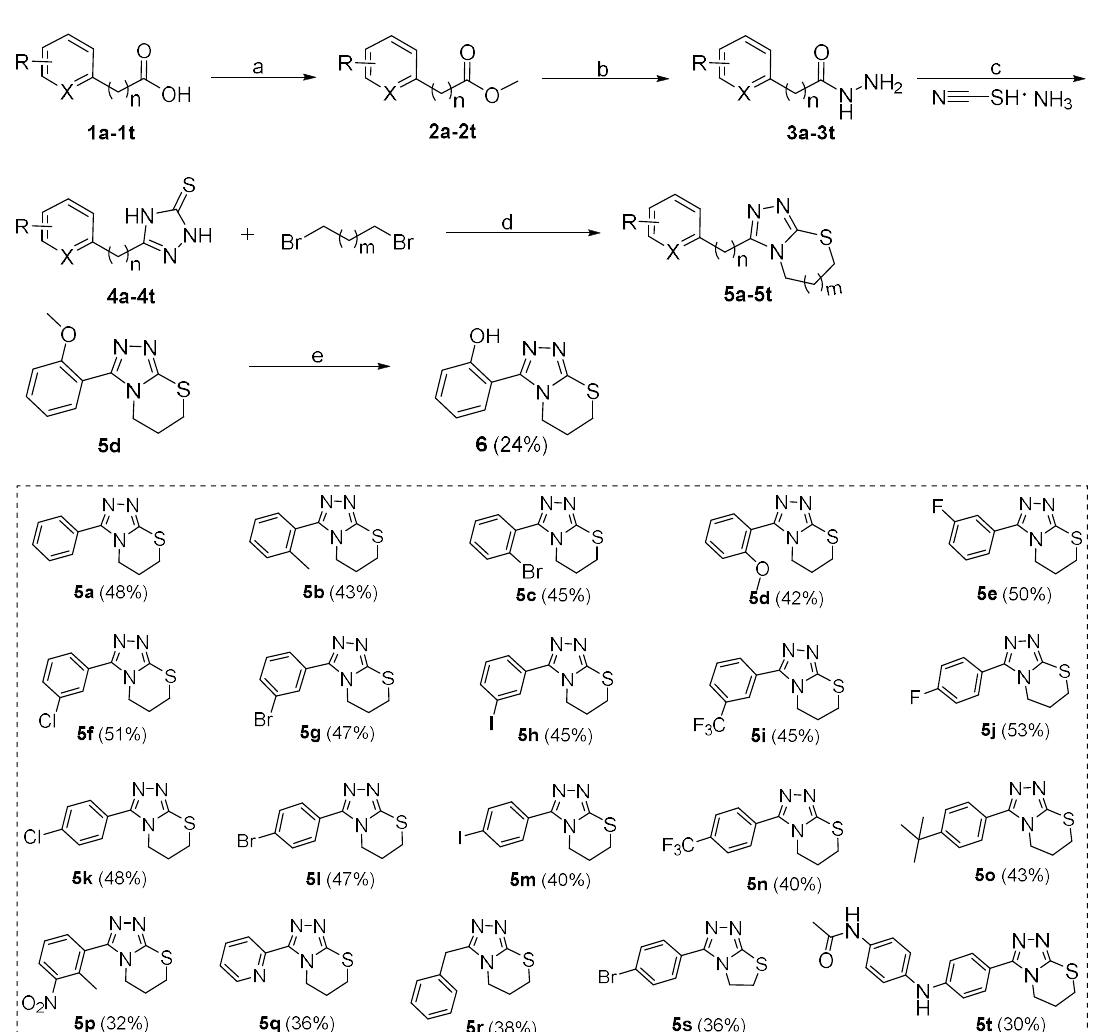
3 of 14 Figure 2. ( a ) Structure of compound 5a . ( b ) Schematic showing subgroups or atoms that were the focus of structural modifications. 2. Results and Discussion 2.1. Chemistry The synthetic routes and total yields of all target compounds are outlined in Schemes 1−3. Compounds 5a – 5t and 6 were synthesized using the reaction sequence shown in Scheme 1. Different carboxylic acids ( 1a – 1t ) were used as the staring materials, and the corresponding esters ( 2a – 2t ) were readily synthesized by reactions of the acids with MeOH in the presence of sulfurous dichloride. The resulting esters 2a – 2t were reacted with hydrazine hydrate to produce the corresponding hydrazides ( 3a – 3t ), followed by reacting with ammonium thiocyanate to afford the 2,4-dihydro-3 H